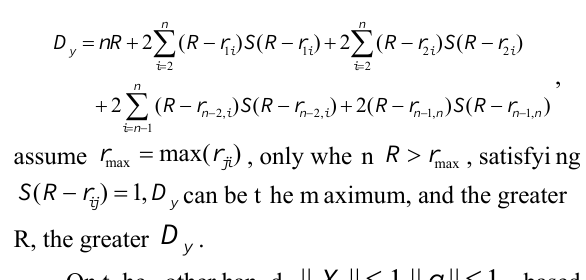
comes into existence . (III) Projection Index Projection index is used to ju dge whether a projec- tion direction is a m eaningful t arget f unction. I n our scheme, we use th e classic projection index to optimize projection direction. T hat i s: Q(a)=S(a)*D(a) , w here S(a) i ndicates ove rall dat a di spersion, D(a) indicates partial data density, a indicates the projection direction. (IV) Optimum Projection Direction Given the high-dimension node attribute matrix, the projection i ndex fun ction will ch ange with pro jection